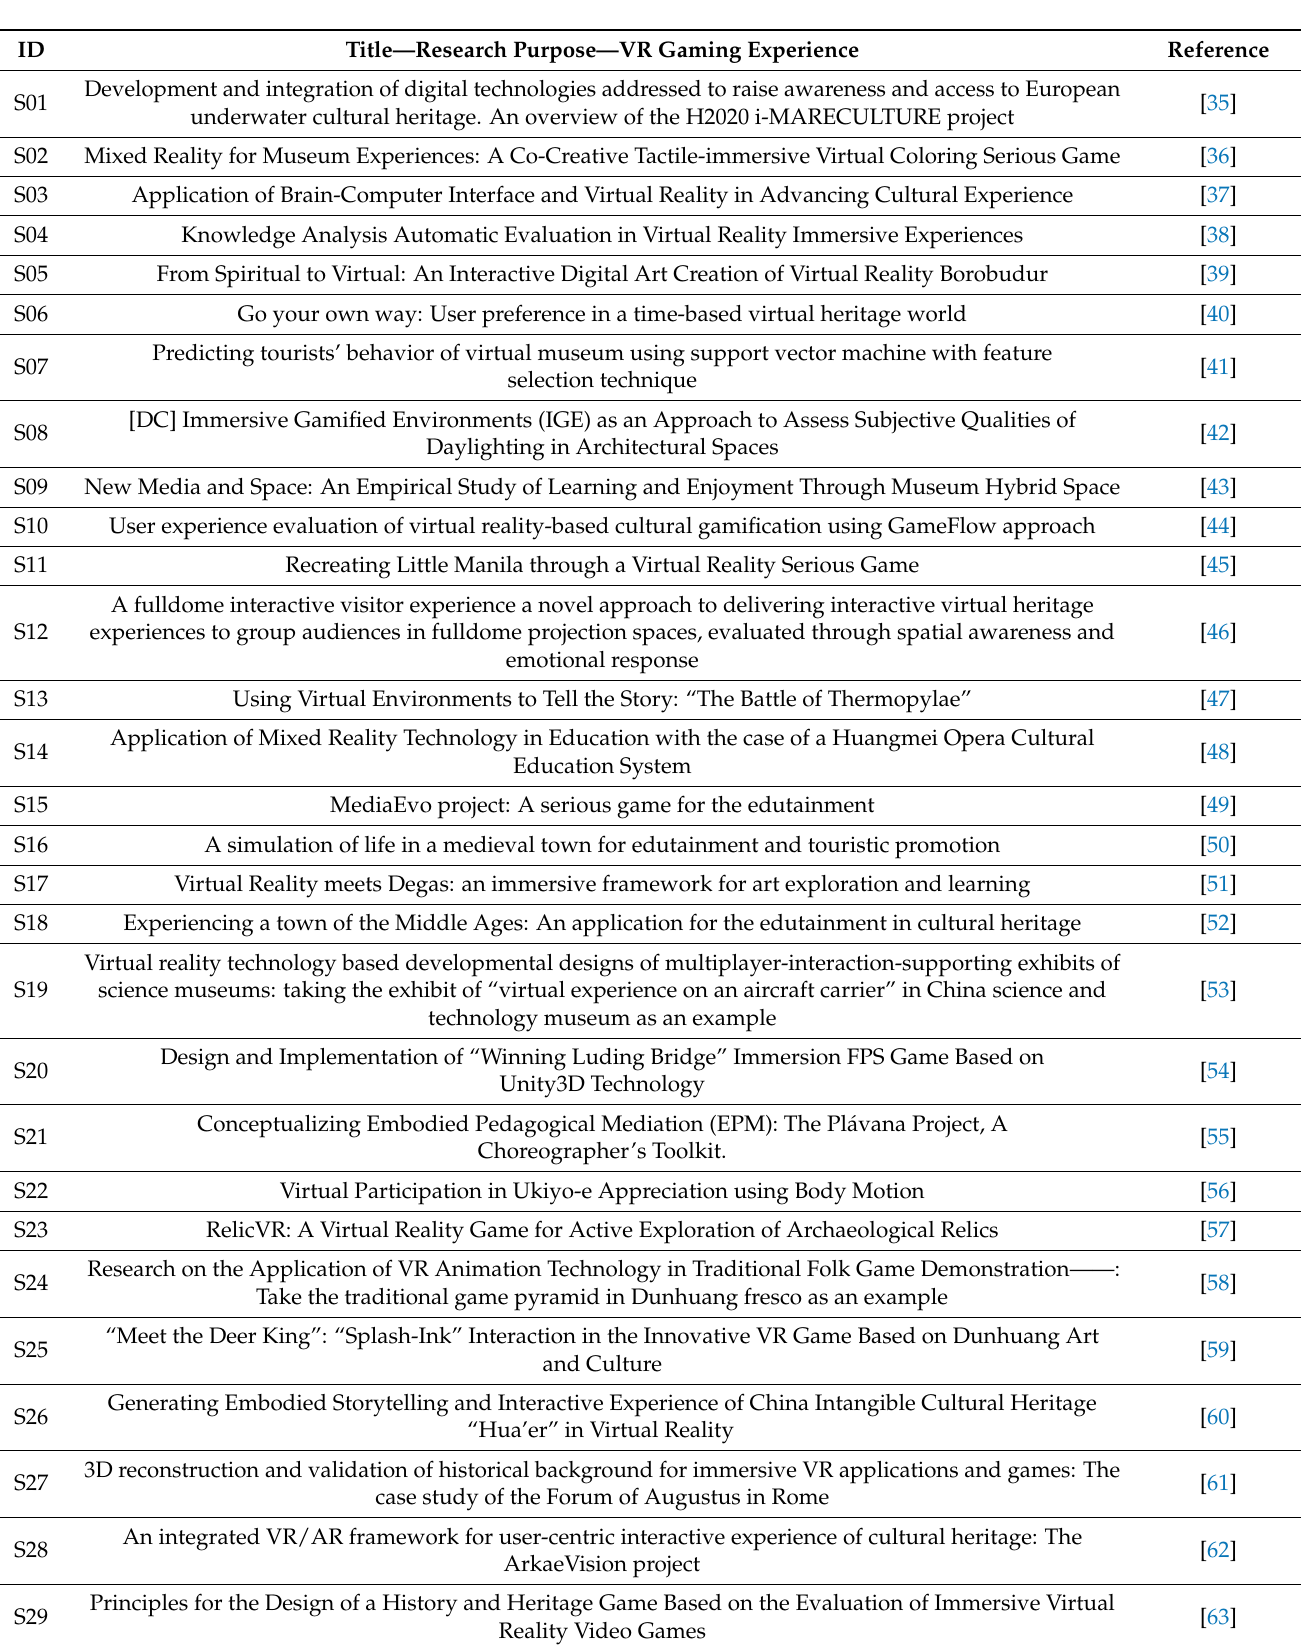
Table 4. Selected studies in this